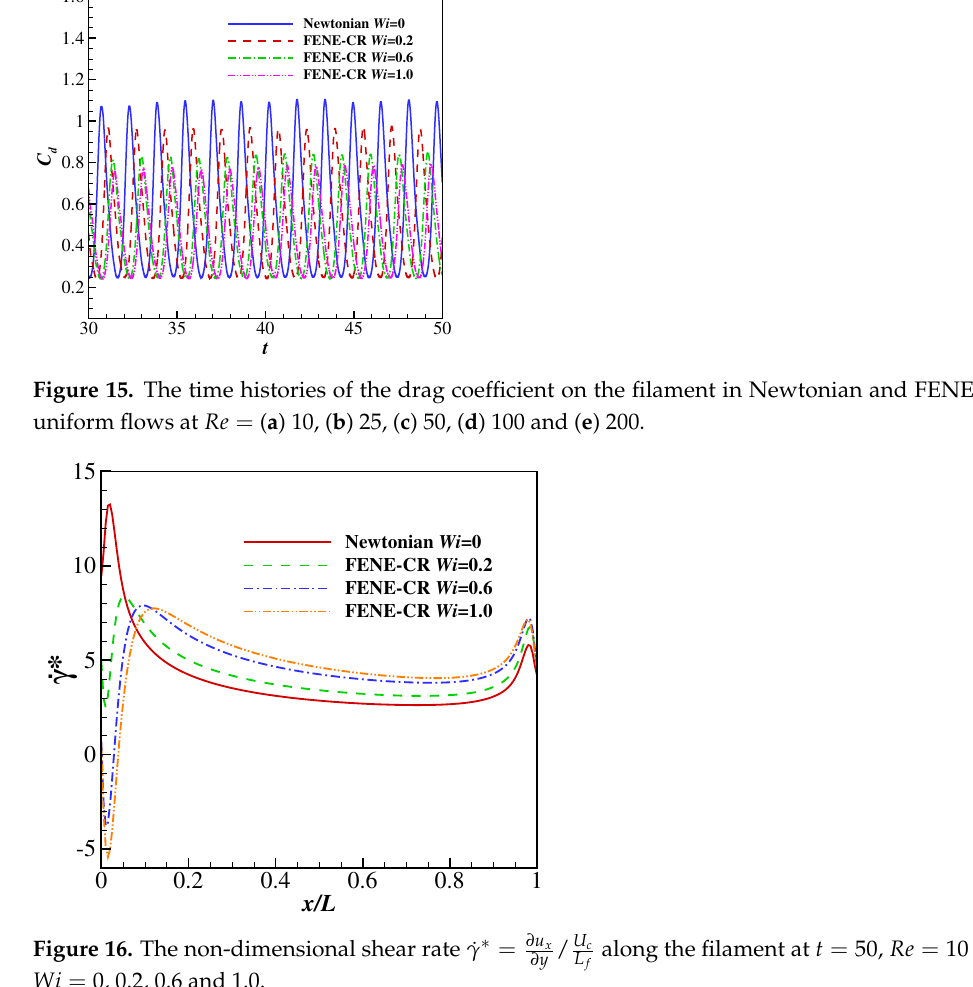
along the filament at t = 50, Re = 10 and / U c L f ∂ y